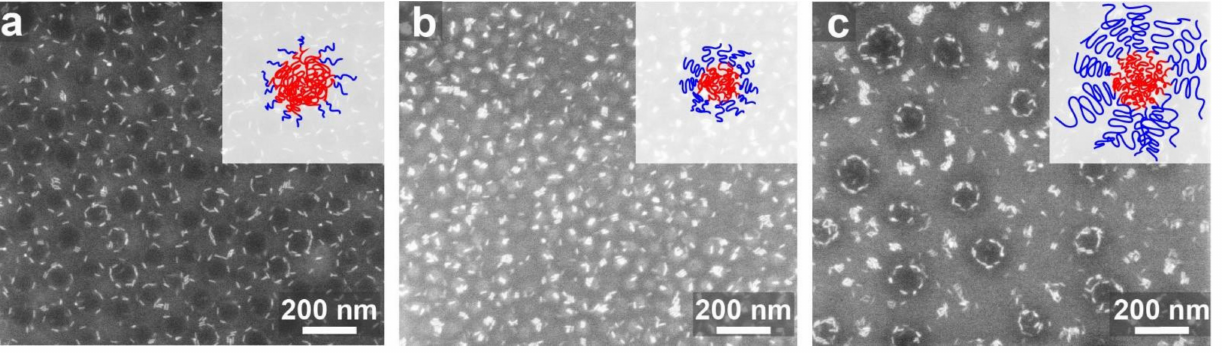
Figure 4. Effect of BCP composition and molecular weight in 0.5 wt.% BCP-based nanocomposites: ( a ) PS 89 - b -P2VP 181 (crew-cut); ( b ) PS 102 - b -P2VP 97 (symmetric); ( c ) PS 380 - b -P2VP 156 (hairy). QR frac- tions were 0.08 in all images. The micelle cores in panel ( b ) appear light because of a charging